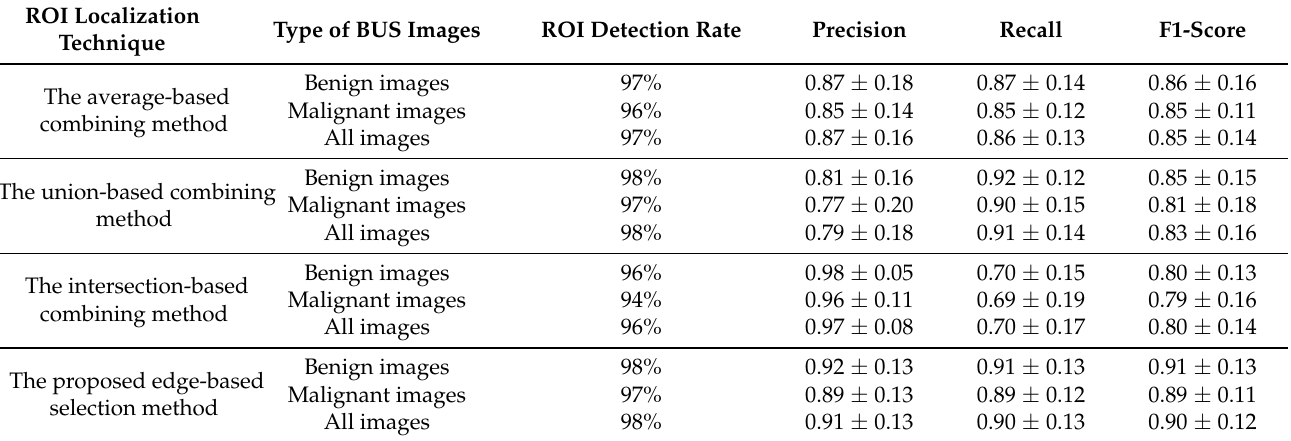
Table 3. Comparison between the ROI detection rates and the mean ± standard deviation precision, recall, and F1-score values obtained by the average-, union-, and intersection-based combination methods and the proposed edge-based selection method based on the UJH